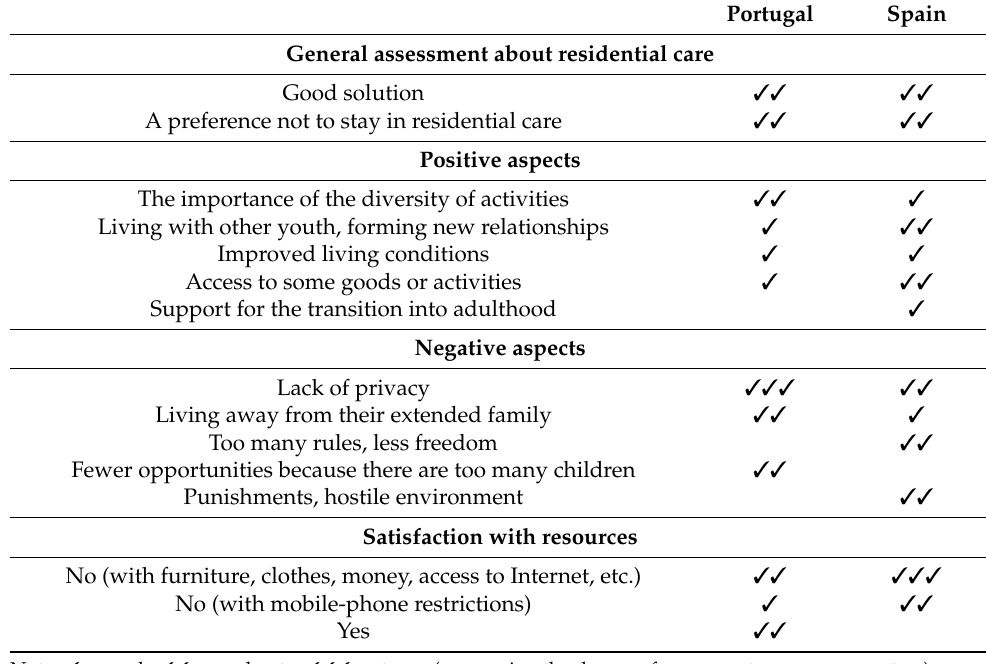
Table 3. Description of subcategories about the fostering experience in residential care by countries.